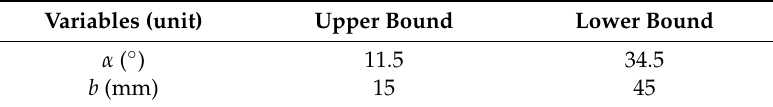
Table 2. The sampling ranges of the design variables.